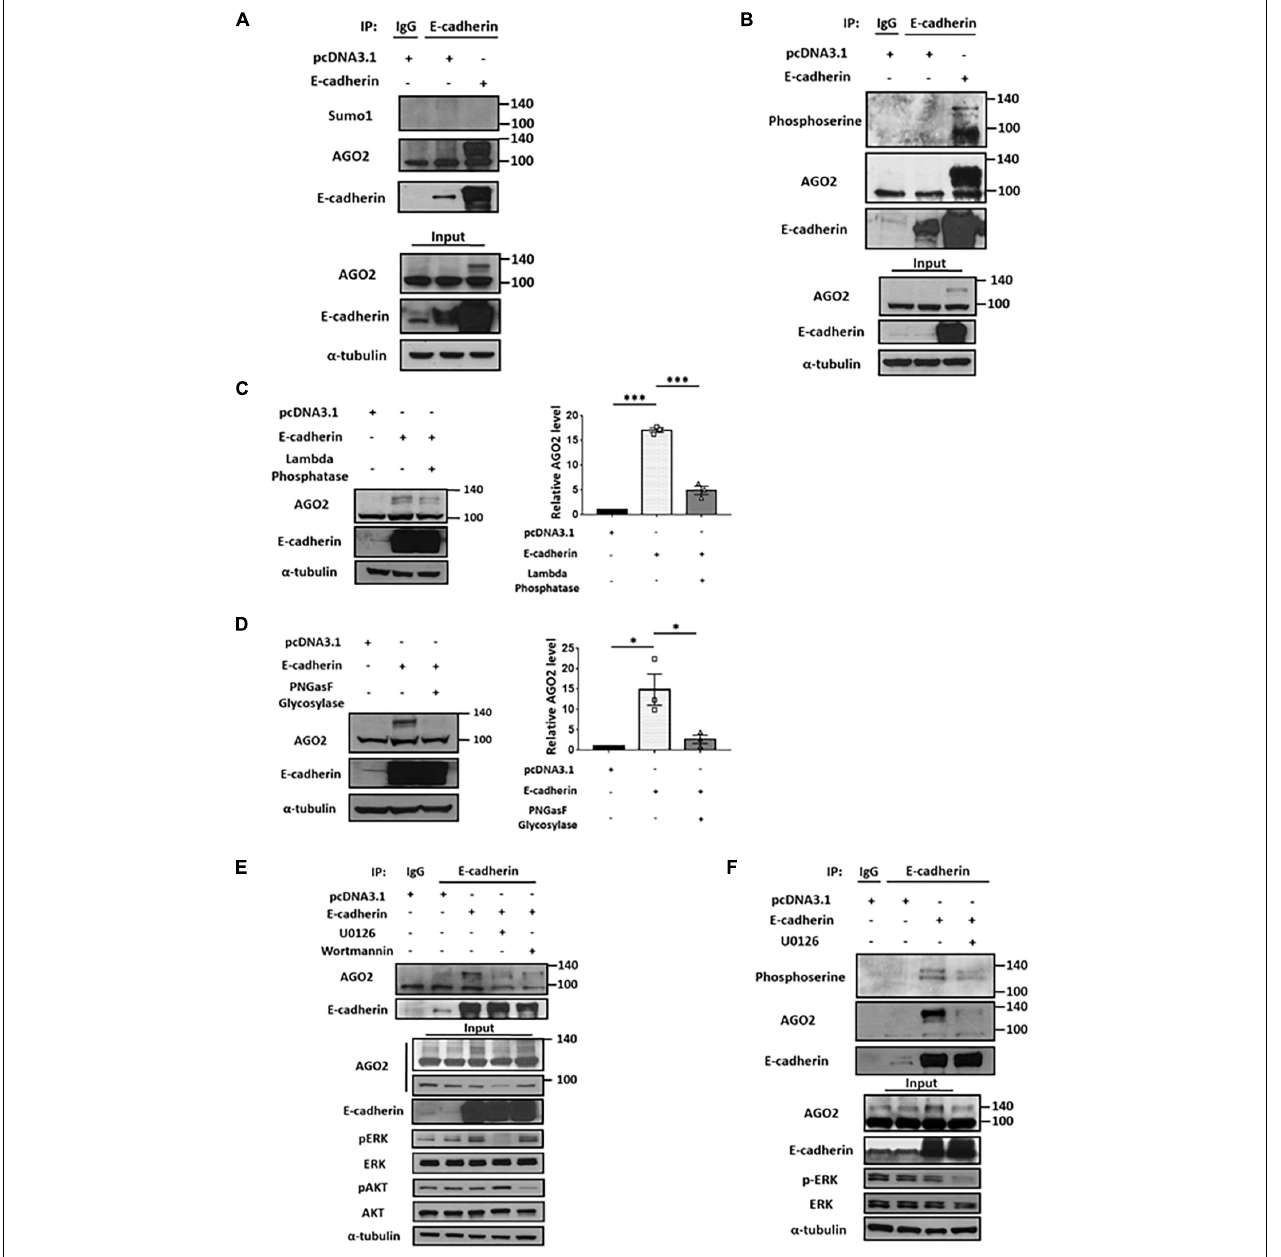
FIGURE 2 | E-cadherin interacts with phosphorylated AGO2. Sumoylation and phosphorylation of AGO2 (A,B) . Detection of AGO2 sumoylation using anti-sumo1 antibody (A) or phosphorylation using anti-phosphoserine antibody (B) in E-cadherin-overexpressing HeLa cells were performed. Effect of lambda phosphatase (C) or PNGasF glycosylase (D) treatments on AGO2 expression in E-cadherin-overexpressing HeLa cells. Repeated data of panels (C,D) (upshifted band of AGO2) were quantitated using image J and repeated at least in three independent experiments (mean ± SEM) and statistically analyzed by one-way ANOVA. ∗ p ≤ 0.05 and ∗∗∗ p ≤ 0.001. (E) Effects of ERK or AKT inhibition on E-cadherin interaction with AGO2. 50 µ M of U0126 and 300 nM of wortmannin were treated for 24 h in E-cadherin-overexpressing HeLa cells. (F) Effects of ERK inhibition on interaction between E-cadherin and phosphorylated AGO2. 50 µ M of U0126 were treated